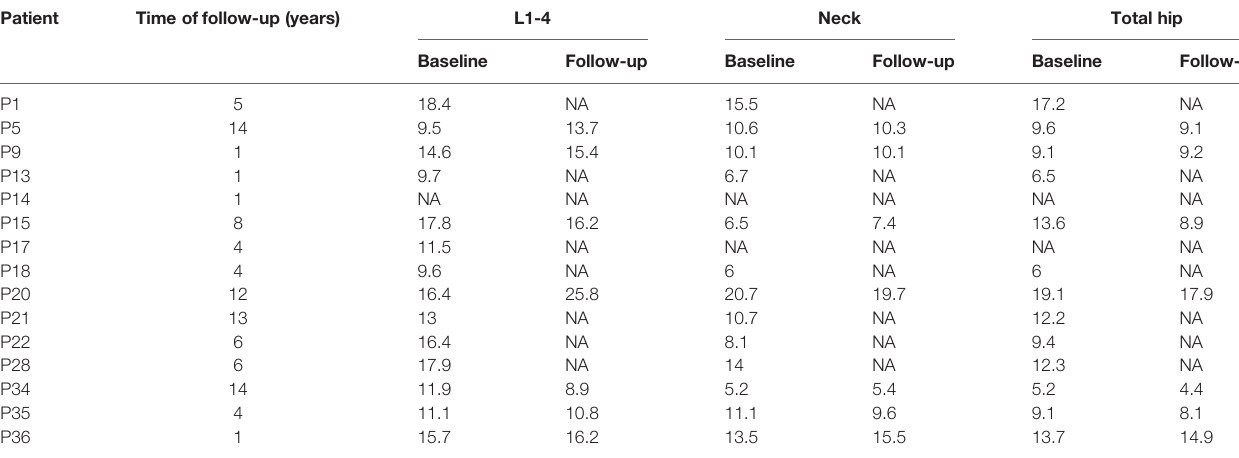
NA, Not available.